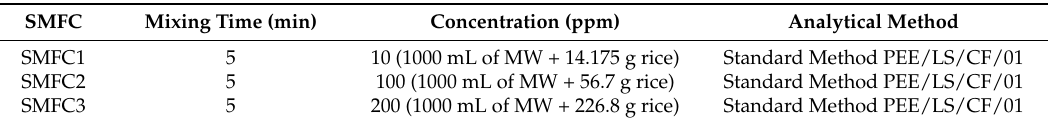
Table 1. Biochemical Oxygen Demand concentrations in the